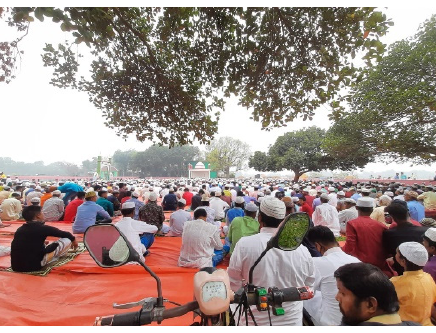
Figure 15. Alt-text: A white and blue embroidered prayer cap on a blue patterned prayer mat.